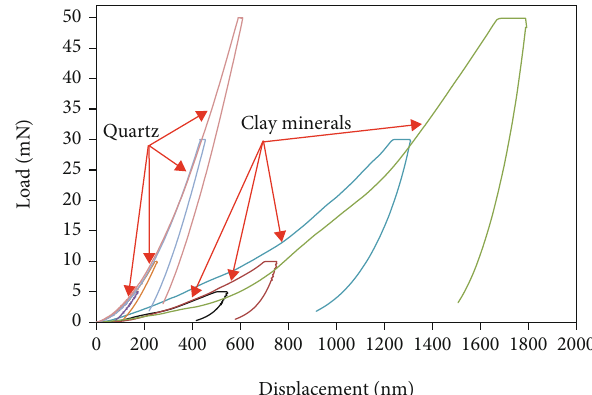
Figure 4: Typical load – displacement curves for quartz and clay minerals in shale at various peak